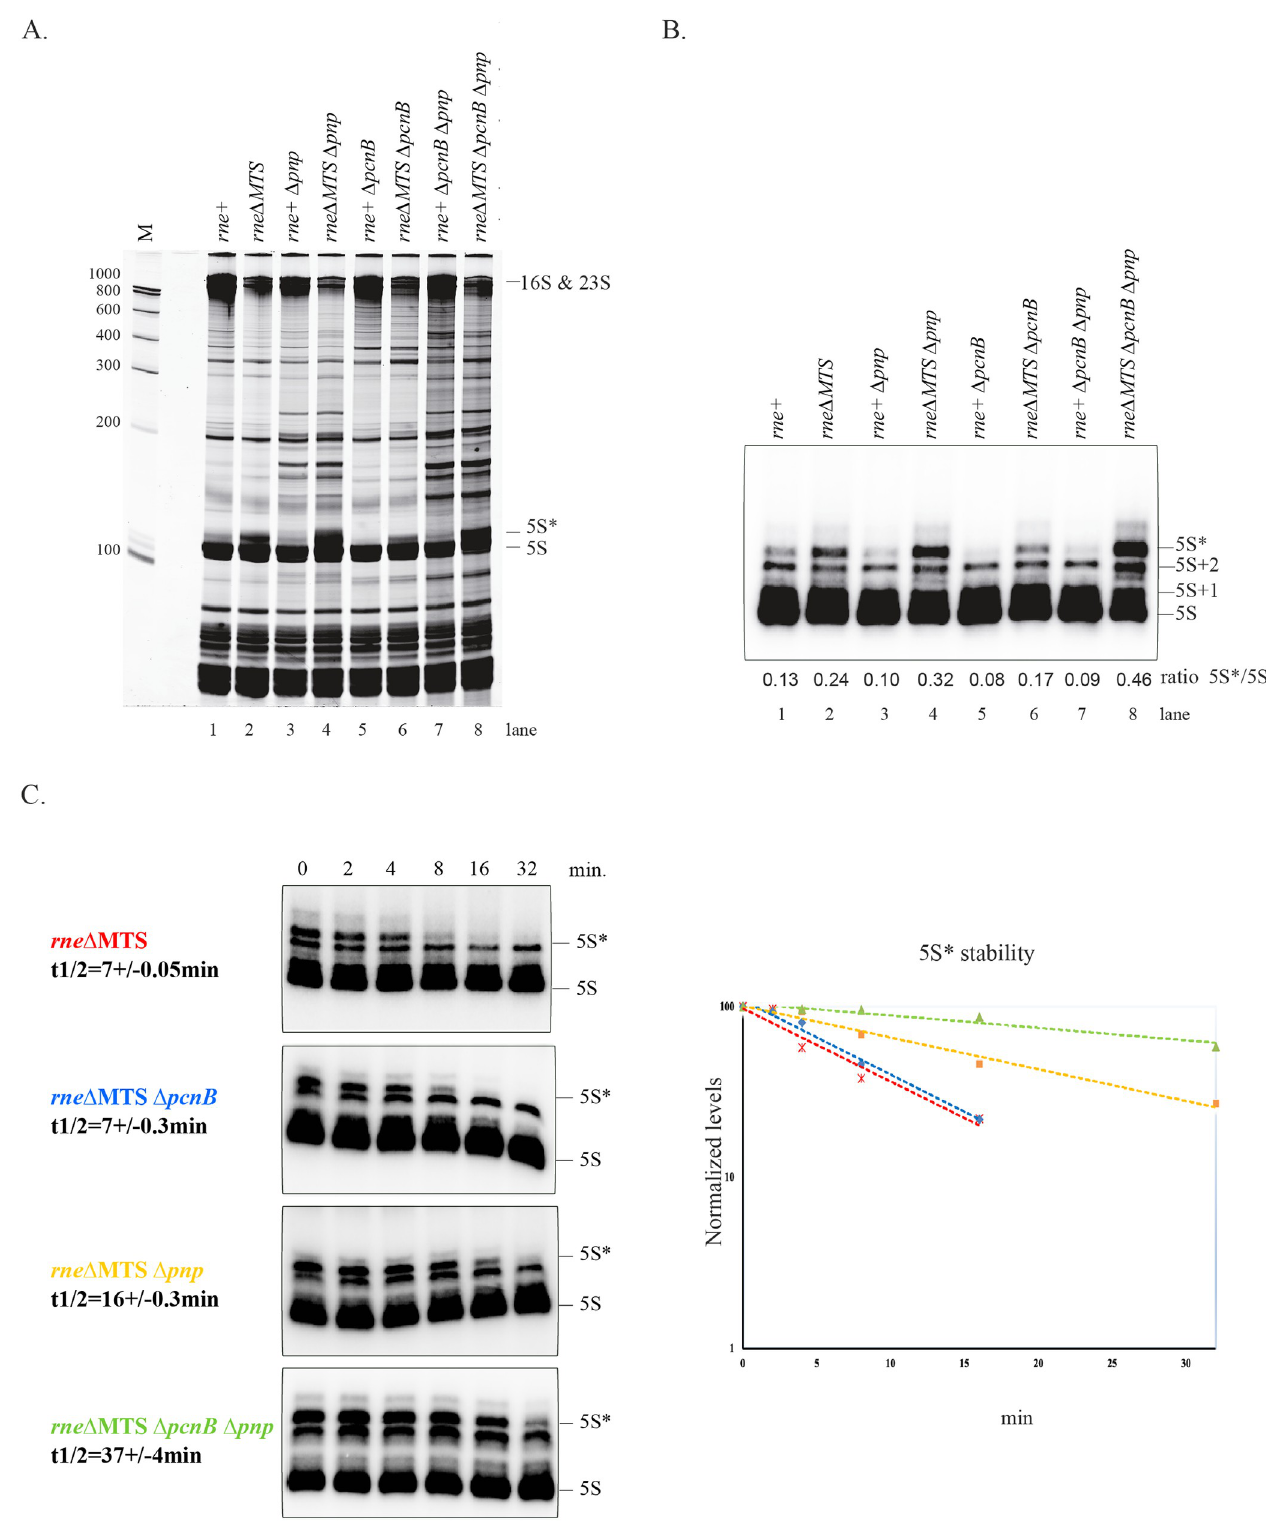
Fig 3. 5S � rRNA is oligoadenylated form of p5S rRNA. (A) Total RNA (10 μ g) was extracted from strains that were grown in LB at 37˚C to OD 600 = 0.4, separated on a denaturing polyacrylamide gel (10%, 7M urea) for 5 h at 300 V in 1 × TBE and then stained with SybrGreen dye. (B) Total RNA (1 μ g)